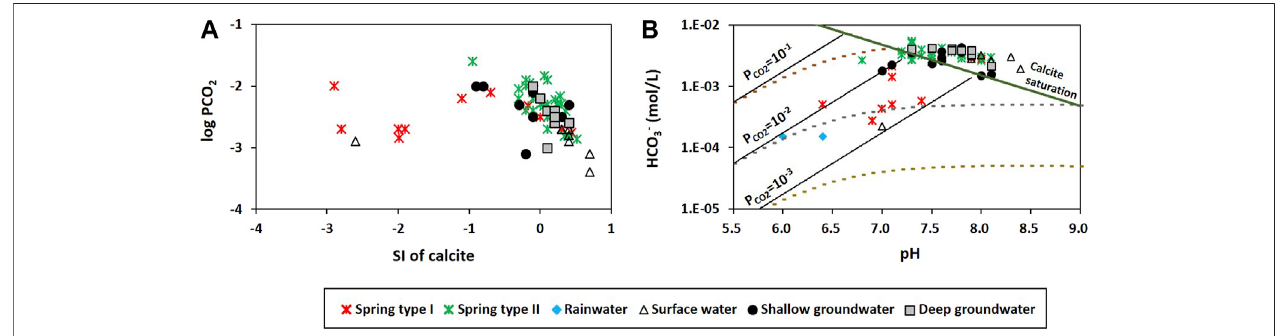
FIGURE 10 | (A) Saturation index (SI) of calcite vs. P CO2 . (B) A diagram of pH versus HCO 3 − showing evolution as water dissolves calcite under open (solid) and closed (dotted) system conditions with varying initial P CO2